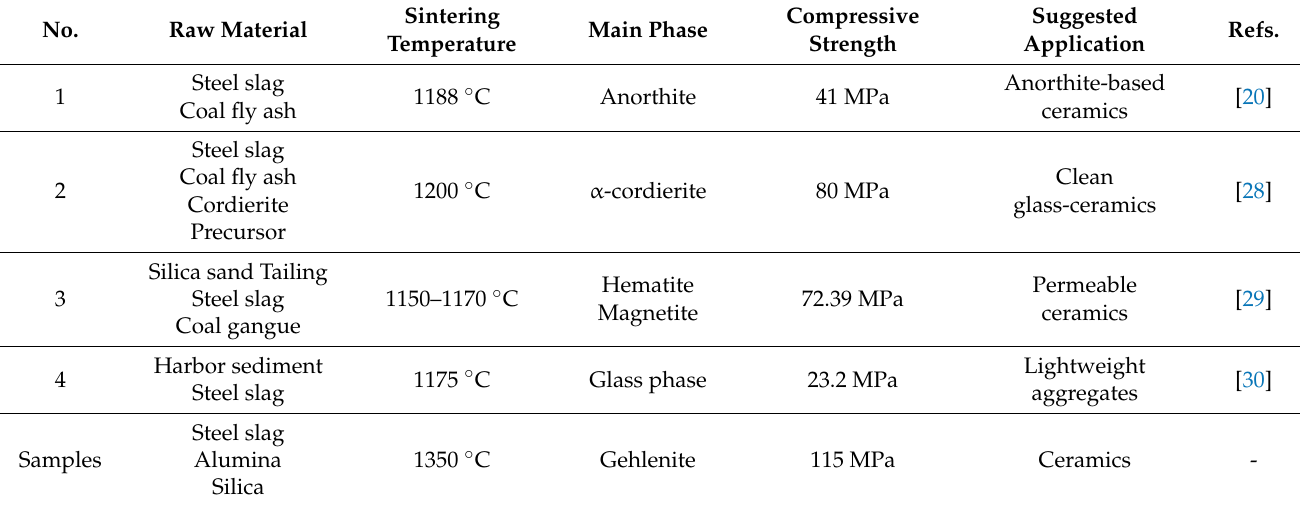
Figure 7. Influence of temperature on the compressive strength and bearing pressure of the modified steel slag. Table 2. Comparison of the mechanical properties for different materials prepared by adding ingredients to steel